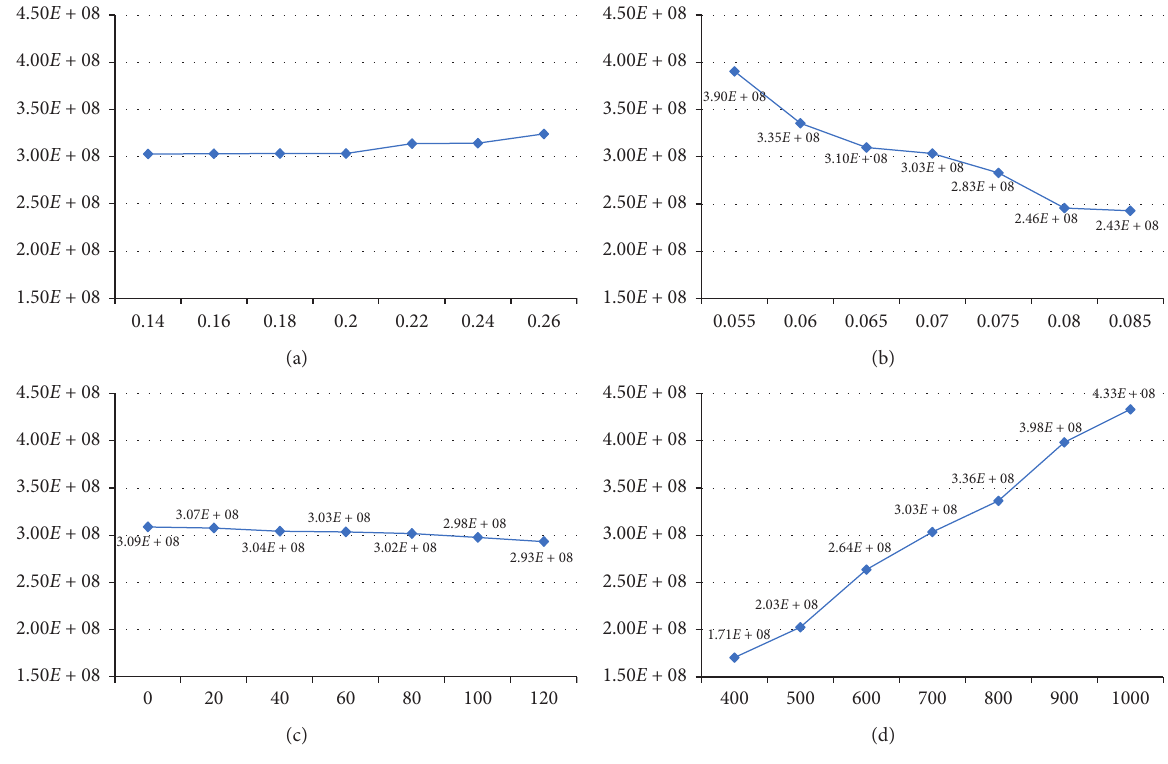
Figure 8: Influence of parameter values on the expected total system cost. (a) Transportation cost (Yuan/ton-km). (b) Pretreatment rate of kitchen waste. (c) Residual value of kitchen waste (Yuan/ton). (d) Penalty cost (Yuan/ton).